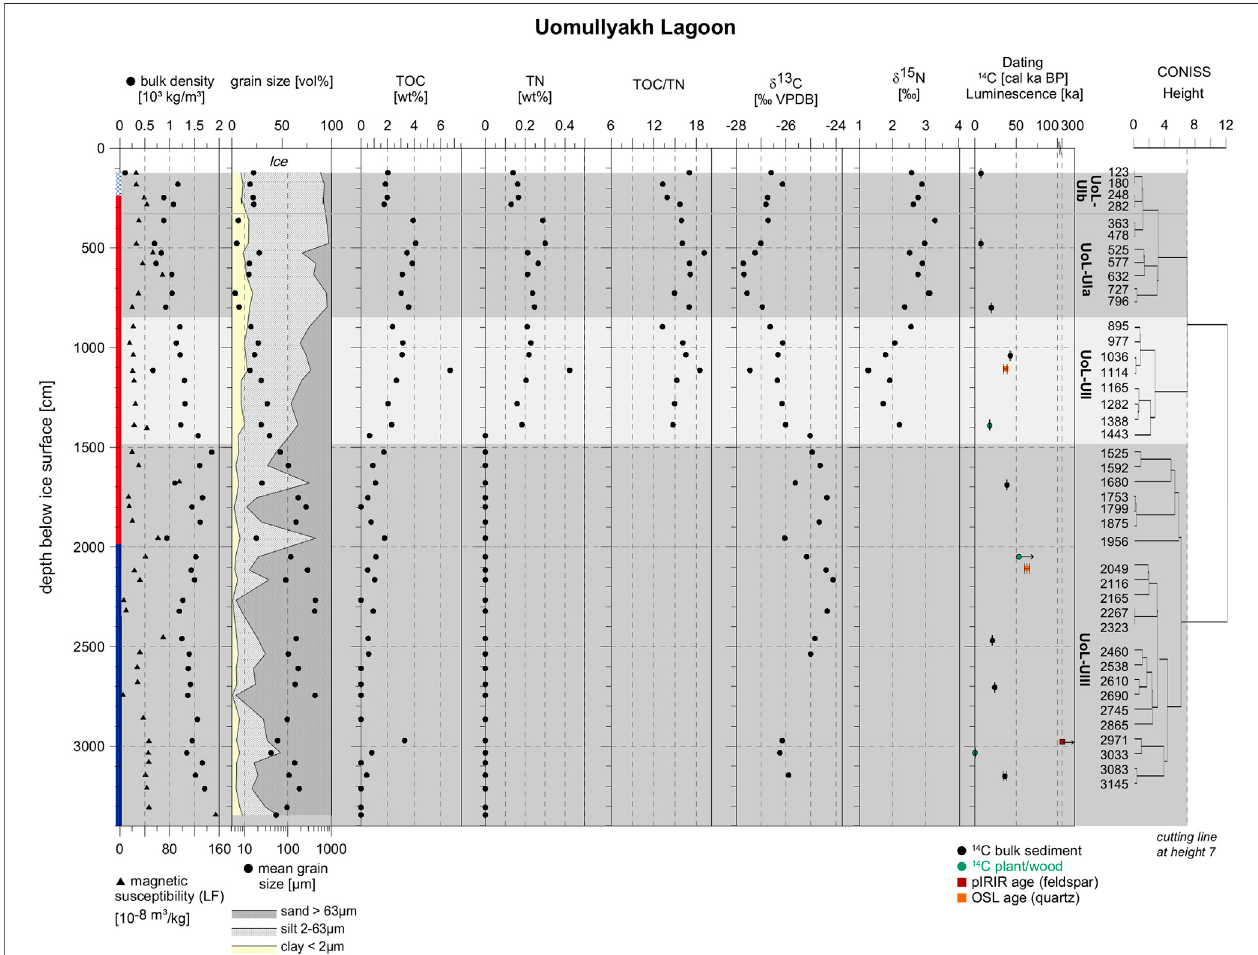
FIGURE 2 | Summary of sedimentological, geochronological and biogeochemical parameters for the Uomullyakh Lagoon core: bulk density (upper axis), mass speci fi cmagneticsusceptibility(loweraxis),grainsize(upperaxis:volumetricproportions, lower axis:meangrainsize), totalorganiccarbon content (TOC),totalnitrogen content (TN), organic carbon and nitrogen ratio (TOC/TN), stable carbon and nitrogen isotope composition ( δ 13 C, δ 15 N), radiocarbon dating ( 14 C) and luminescence dating (pIRIR, OSL). The top 120 cm is the overlying ice cover. The core was divided into three stratigraphic units based on a CONISS analysis. Color bar at the y -axis indicates frozen (blue), unfrozen (red) and partially frozen (shaded) core segments. Note that “ frozen ” includes visibly frozen core sections and re-constructed frozen conditions. Arrows indicate non- fi nite ages.